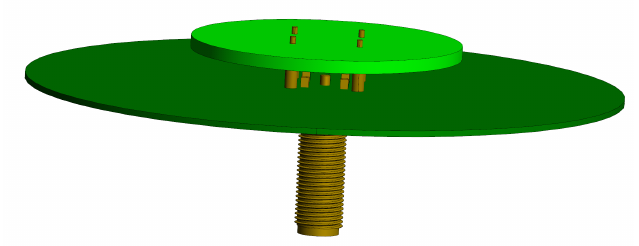
Figure 4. Custom 2.4-GHz